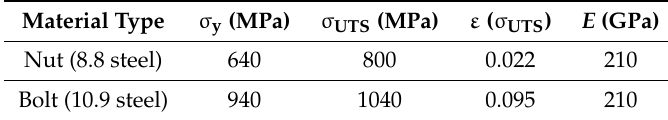
Table 1. Elastic–plastic properties for the bolt and nut materials .